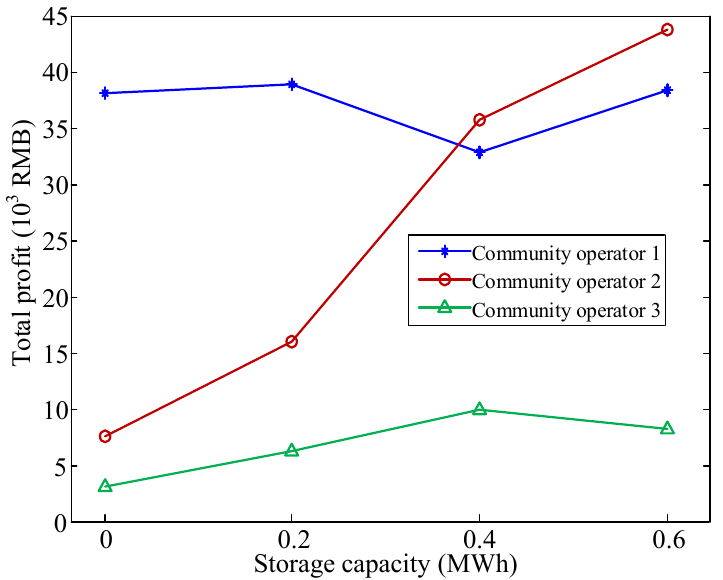
Figure 4. Total profit of 3 community operators for different storage